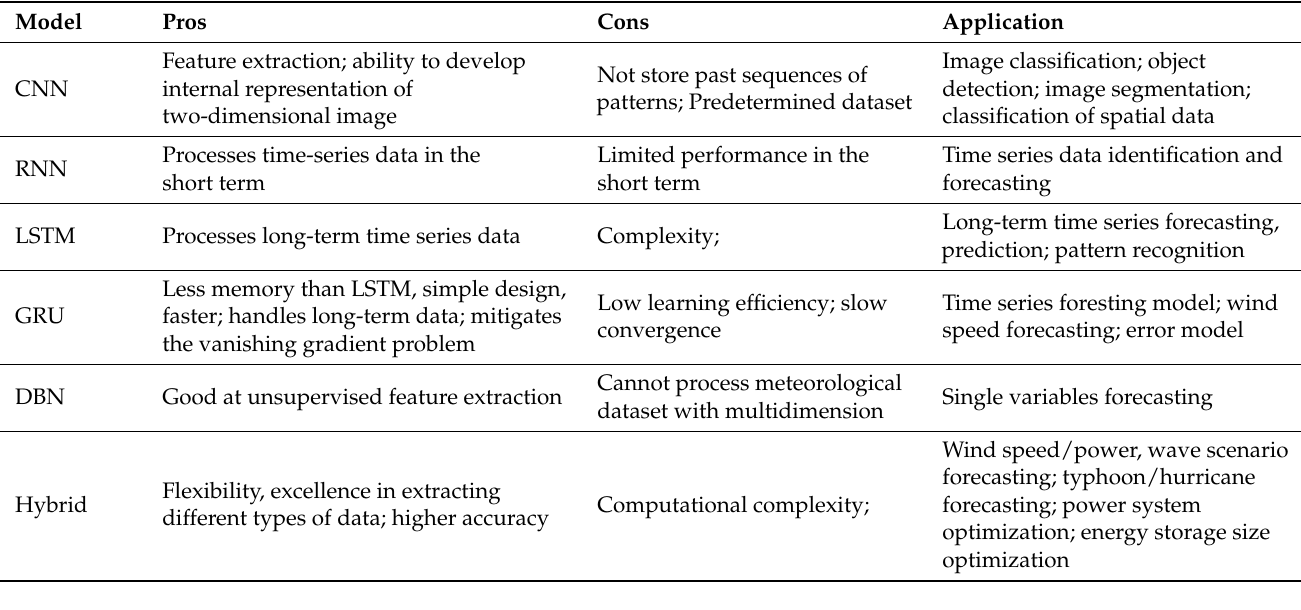
Table 5. Summary of different deep learning models.